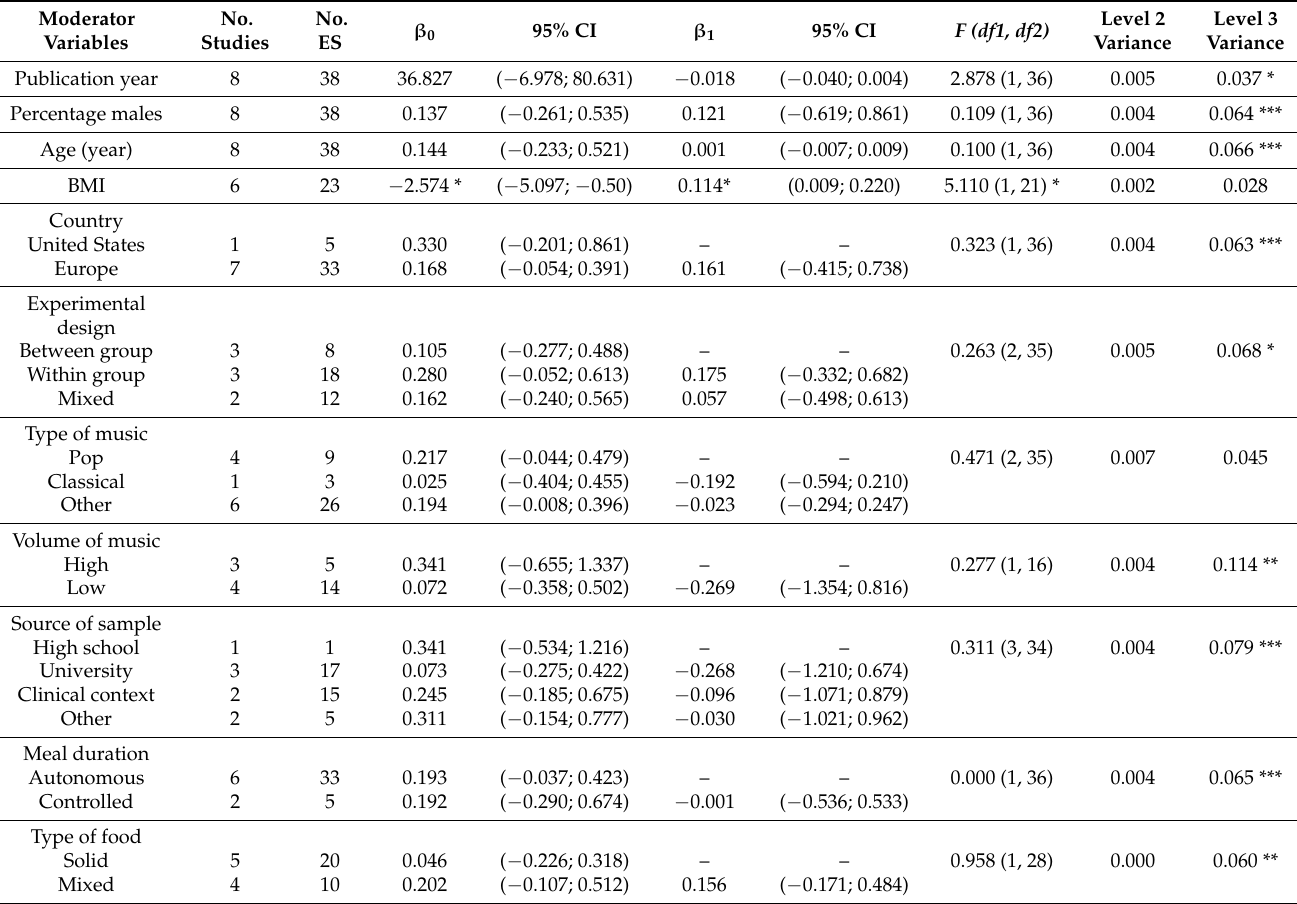
Table 1. Results of Moderator